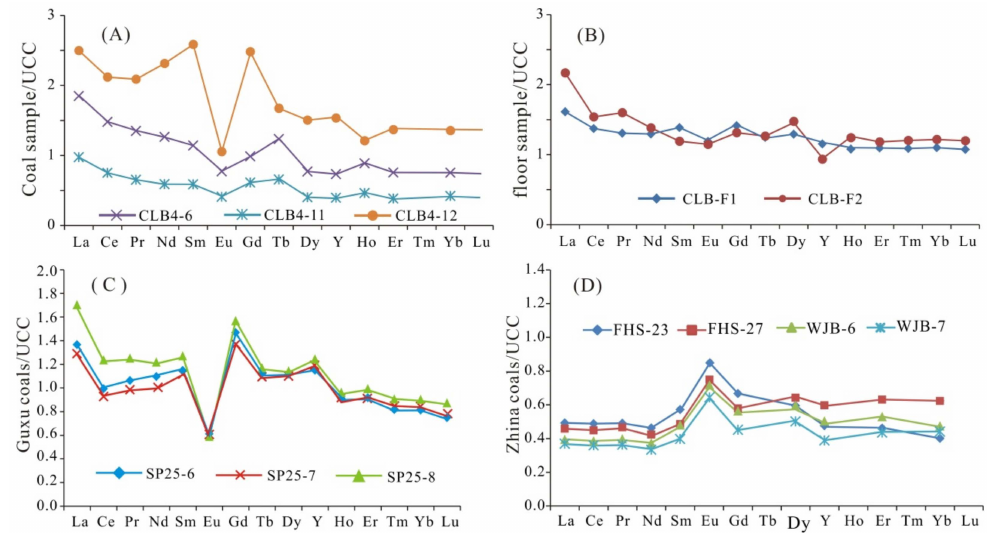
Figure 13. Distribution patterns of rare earth elements and yttrium (REY) in the study coals ( A ), floor rocks ( B ), Guxu coals ( C ) [21], and Zhina coals ( D ) [12]. REY are normalized to Upper Continental Crust